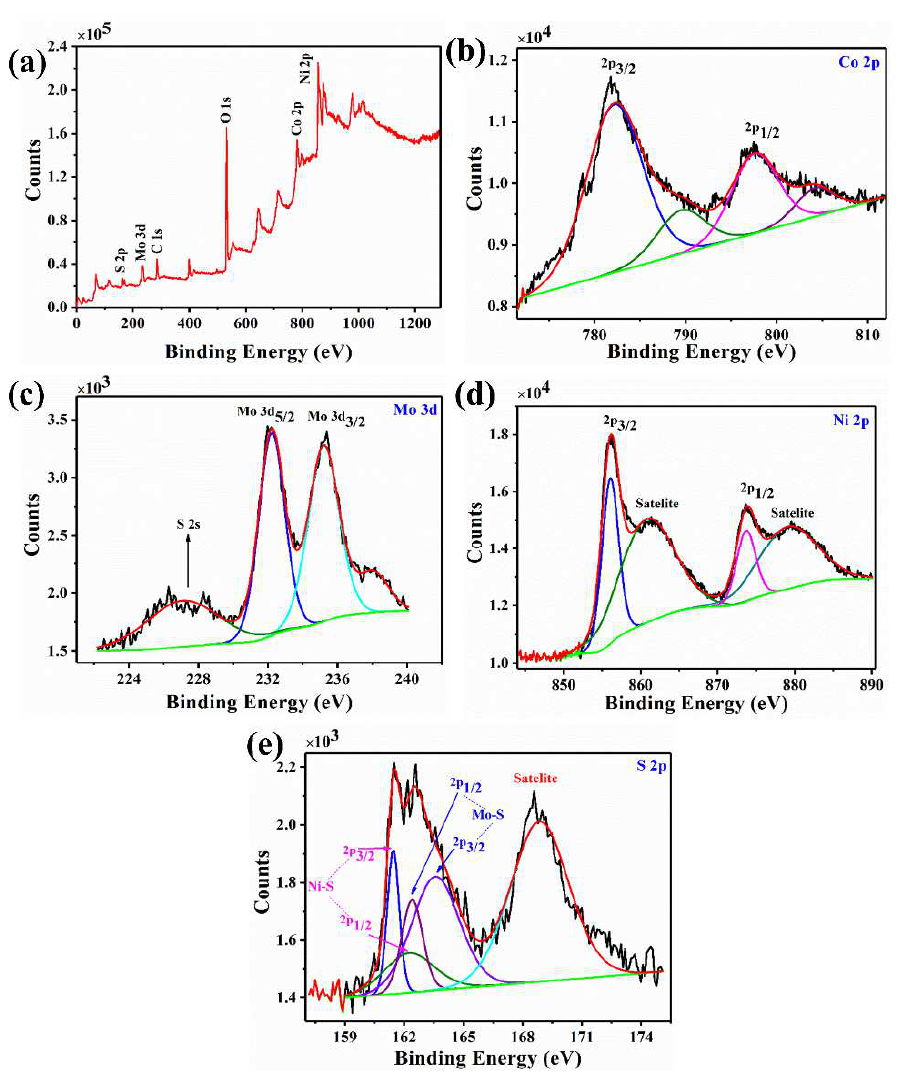
Figure 5. XPS of NCMS: ( a ) survey spectrum and ( b ) Co 2p, ( c ) Mo 3d, ( d ) Ni 2p, and ( e ) S 2p core-level spectrum.